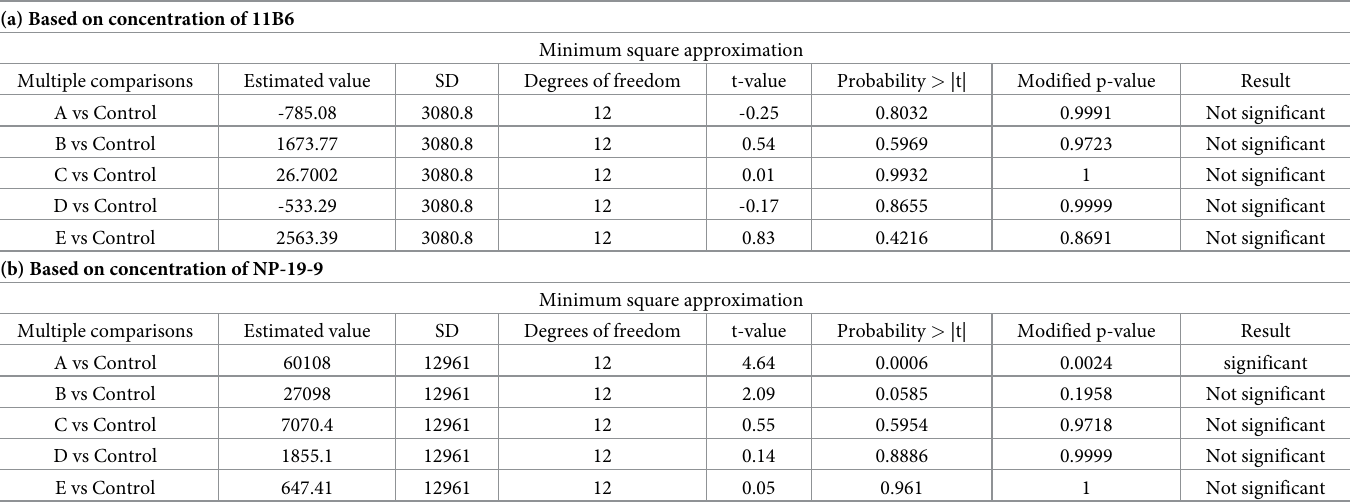
Table 8. Multiple neutralization test comparisons of the mAbs (RFFIT against CVS-11 rabies virus strain). (a) Based on concentration of 11B6